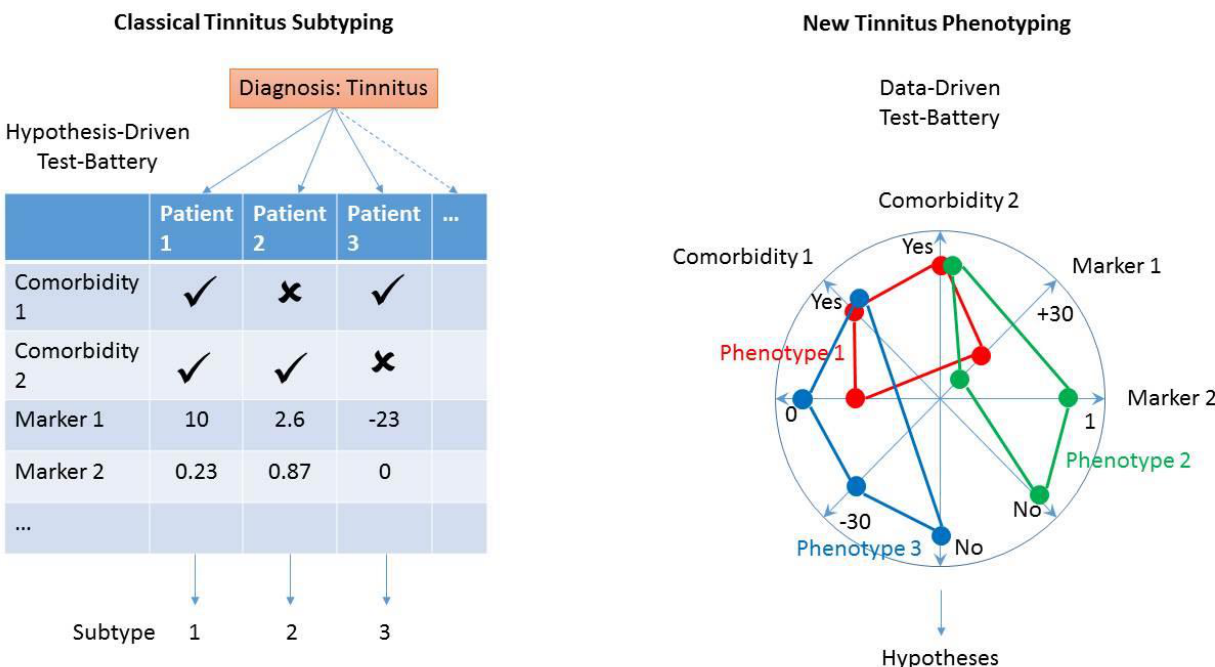
Figure 3. From classical, hypothesis-driven phenotypes to new, data-driven phenotypes. In classical tinnitus subtyping ( left ), tinnitus subtypes are the result of hypotheses assuming tinnitus to be associated with certain comorbidities, facultatively complemented by a number of test markers (presence indicated by ✓ , absence indicated by ). In our alternative approach ( right ), tinnitus subtypes result from clustering of an arbitrary number of test markers and diagnostic findings.